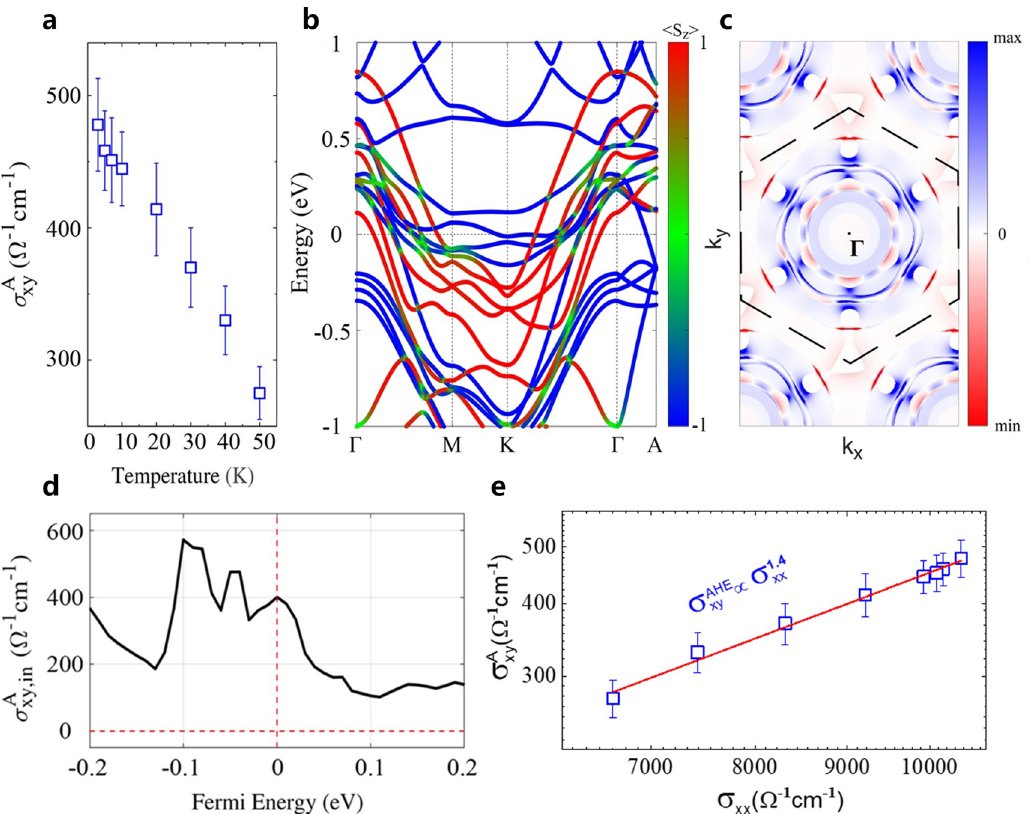
Fig. 2 Anomalous Hall conductivity and nontrivial band structure. a Temperature-dependent anomalous Hall conductivity in S1. b , c Band-structure of (cid:5) (cid:6) Fe 1/3 TaS 2 . The colours mark the spin expectation S z of the band. d Berry curvature distribution in k z ¼ 0 plane. d Fermi energy E F -dependent intrinsic